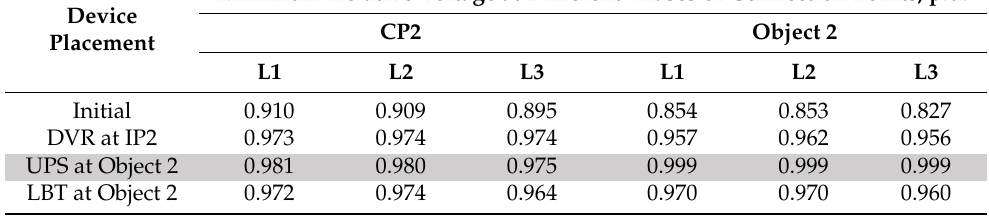
Table 6. Comparison of solutions for Object 2.